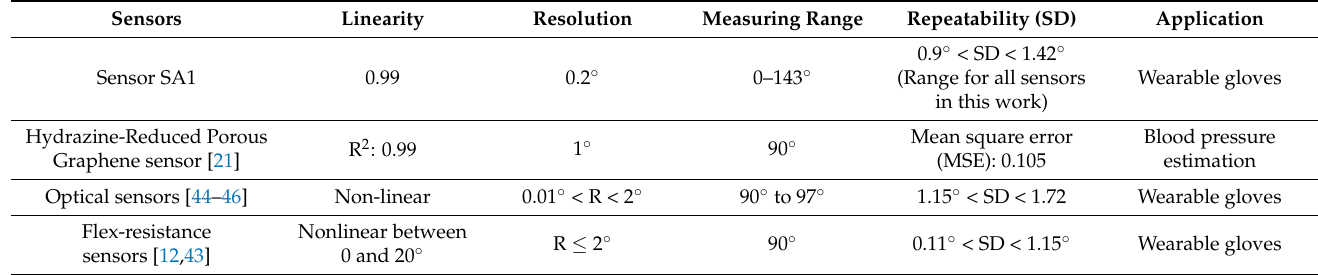
Table 3. Comparison of bending